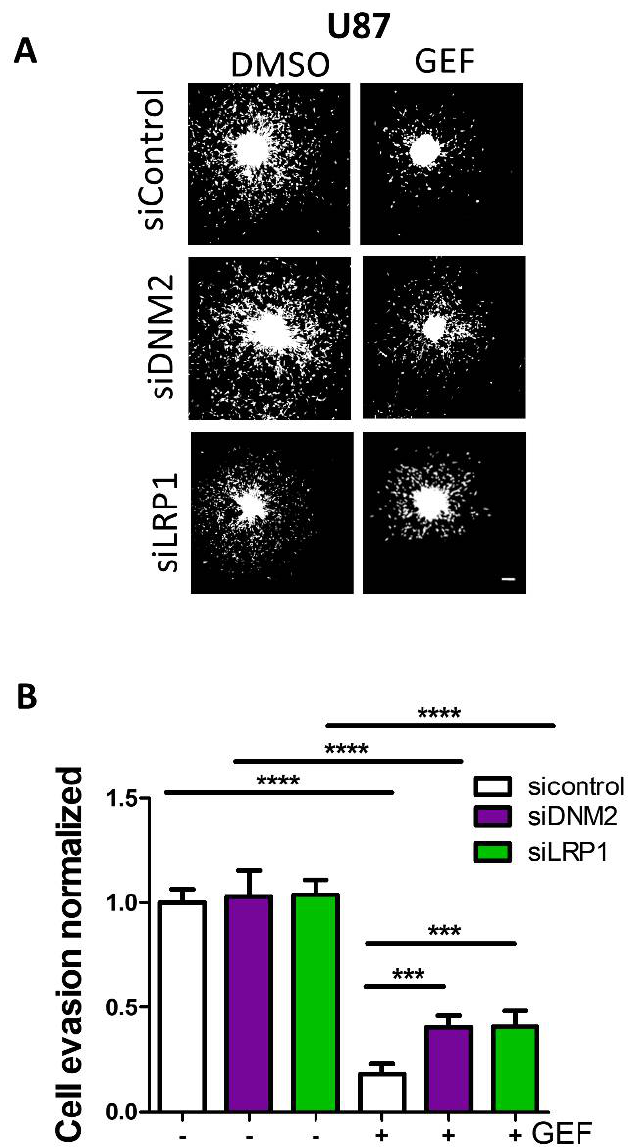
Figure 7. DNM2 or LRP-1 silencing decreases gefitinib efficacy on cell evasion. ( A ) U87 transfected with siRNA-control or siRNA targeting DNM2 or LRP-1 two-day-old spheroids were plated onto collagen-I-coated (10 µg·mL −1 ) plastic dishes. After 24 h of gefitinib treatment, spheroids were fixed, and nucleus were labelled by DAPI staining. Fluorescent microscopy images of representative spheroids after 24 h of migration were taken. Scale bar: 300 µm. ( B ) After DAPI staining, the number of evading cells was quantified by automated counting of nuclei using a previously validated ImageJ home- made plugin. Data are represented in column histograms. *** p < 0.001, **** p < 0.0001.